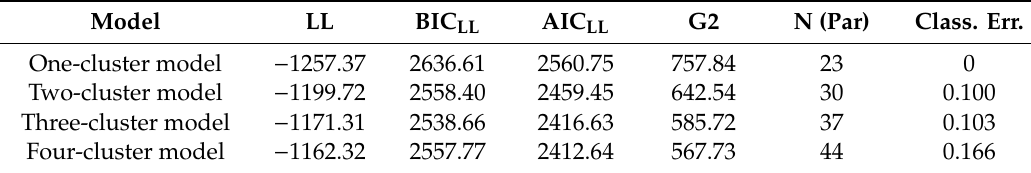
Table 4. Latent class cluster models’ goodness-of-fit measurements ( n =